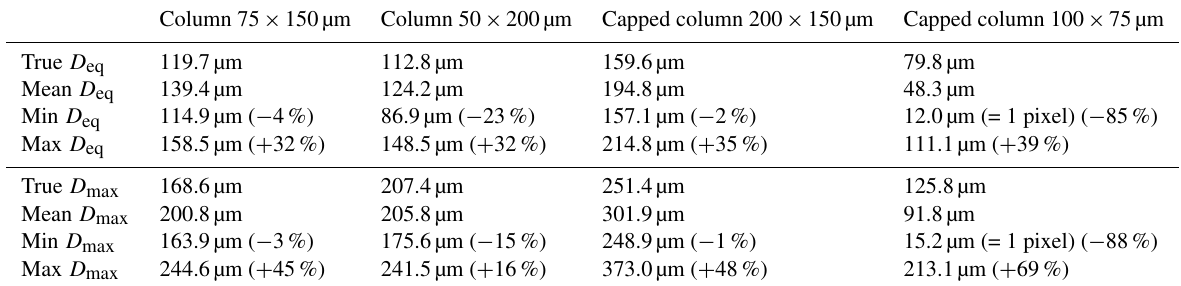
Table 1. True D eq and D max of particles shown in Fig. 8 compared with the minimum, maximum, and average theoretical D eq and D max over the whole distance between the two arms of the 2D-S probe. The minimum and maximum relative errors with respect to true D eq and D max are shown in brackets behind minimum and maximum diameter values.